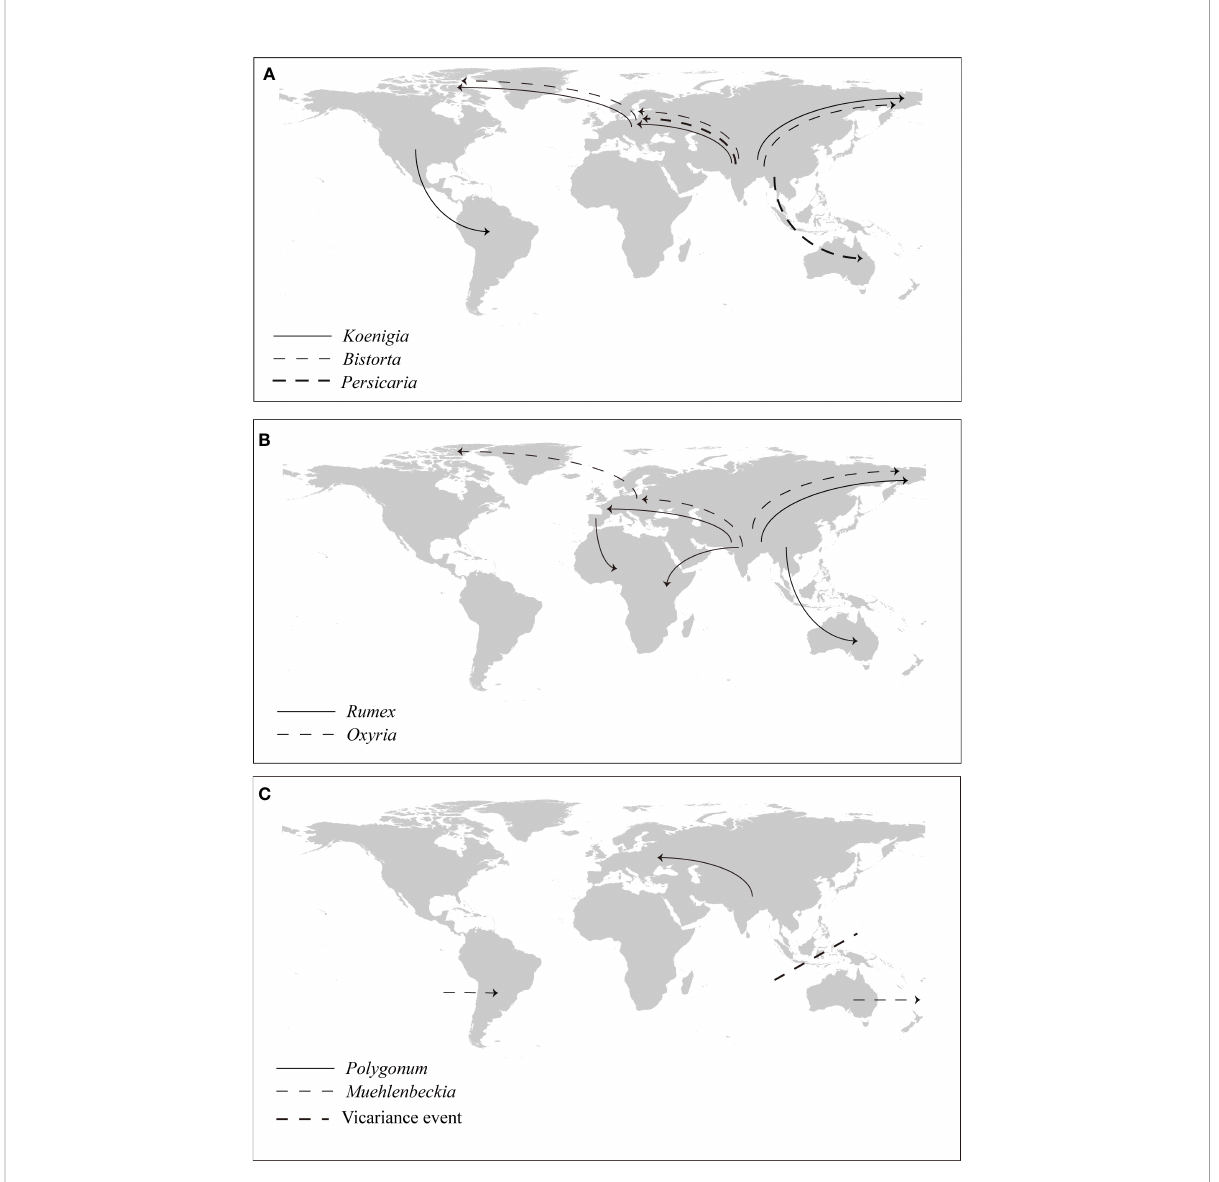
FIGURE 6 Vicariance and dispersal events in Polygonoideae. (A) Dispersal events in Persicarieae, (B) dispersal events in Rumiceae, (C) Vicariance and dispersal events in